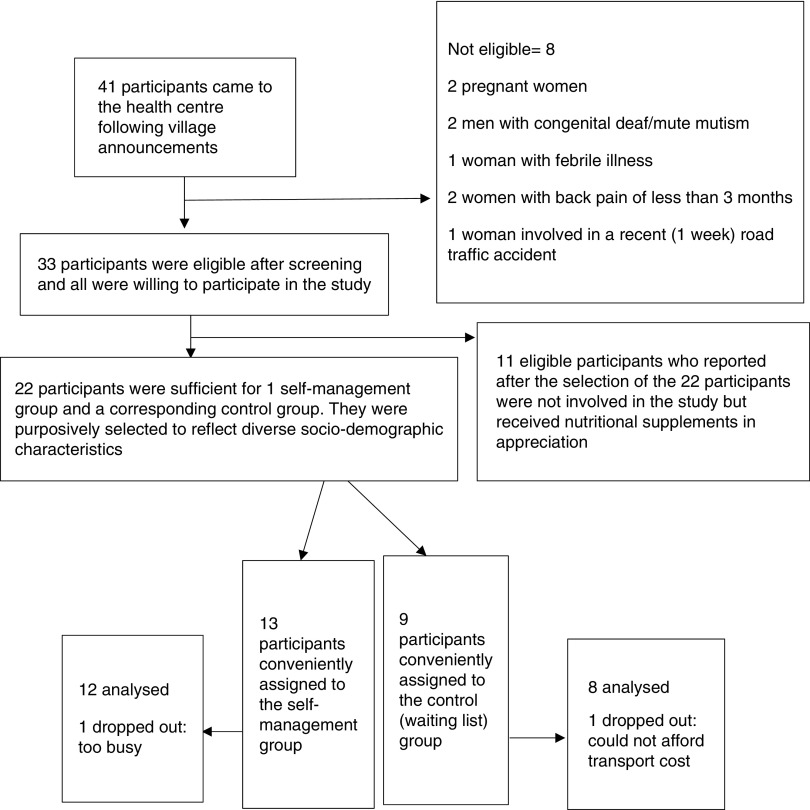
Recruitment process